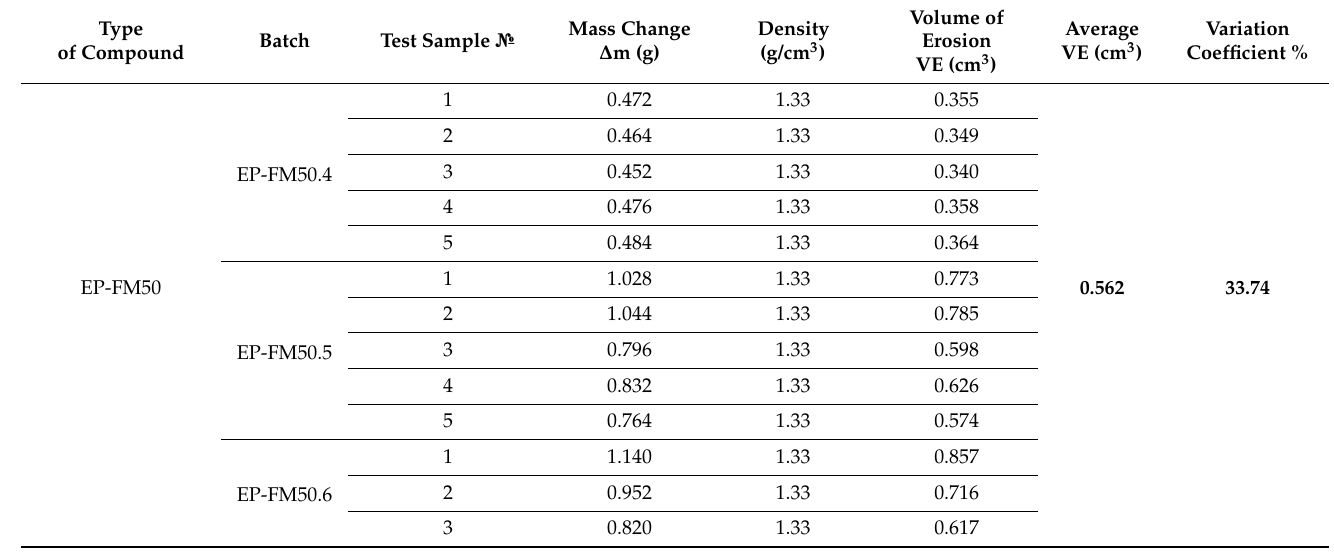
Table A20. Wear of filled epoxy binder (EP-FM50) at 23 ◦ C at an impingement angle of 45 ◦ .